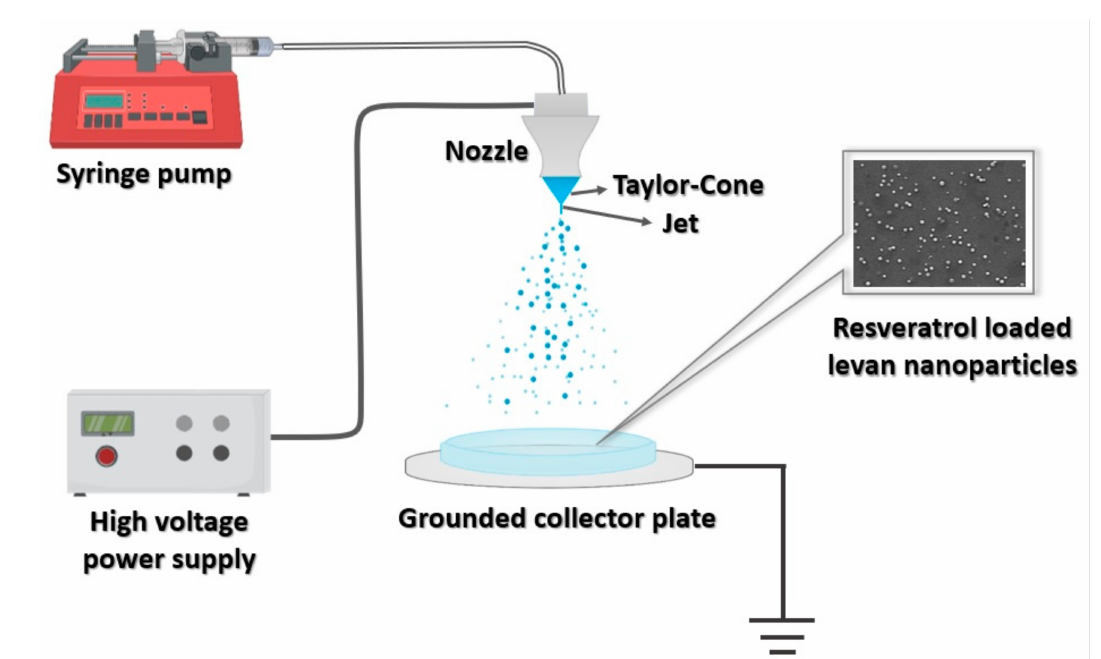
Figure 1. Schematic illustration of the experimental set-up of the EHDA process for the fabrication of